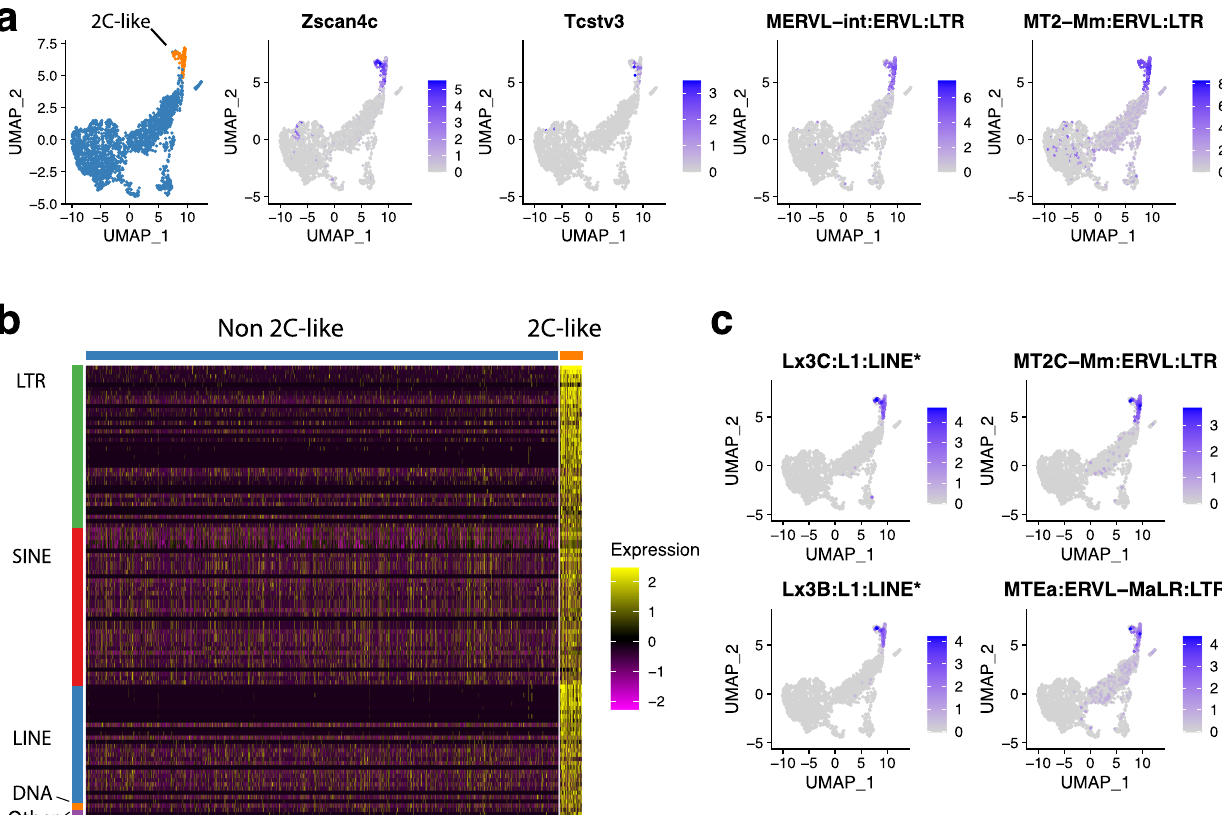
Fig. 4 SoloTE analysis results during the murine embryonic 2-cell stage. a UMAP plots depicting cell groups (2C-like cells in orange, and non 2C-like in blue), 2C-like known cell markers ( “ Zscan4c ” and “ Tcstv3 ” ), and previously known TEs expressed in 2C-like cells ( “ MERVL-int:ERVL:LTR ” and “ MT2- Mm:ERVL:LTR ” ). b Heatmap of all TEs differentially expressed in the 2C-like cells found using SoloTE. Cell types are indicated above (non 2C-like in blue, and 2C-like in orange), and TE classes are indicated on the left (LTRs in green, SINEs in red, LINEs in blue, DNA TEs in orange, and Other TEs in purple). c UMAP plots of TEs detected exclusively with SoloTE in the 2C-like cells. “ * ” denotes locus-speci fi c